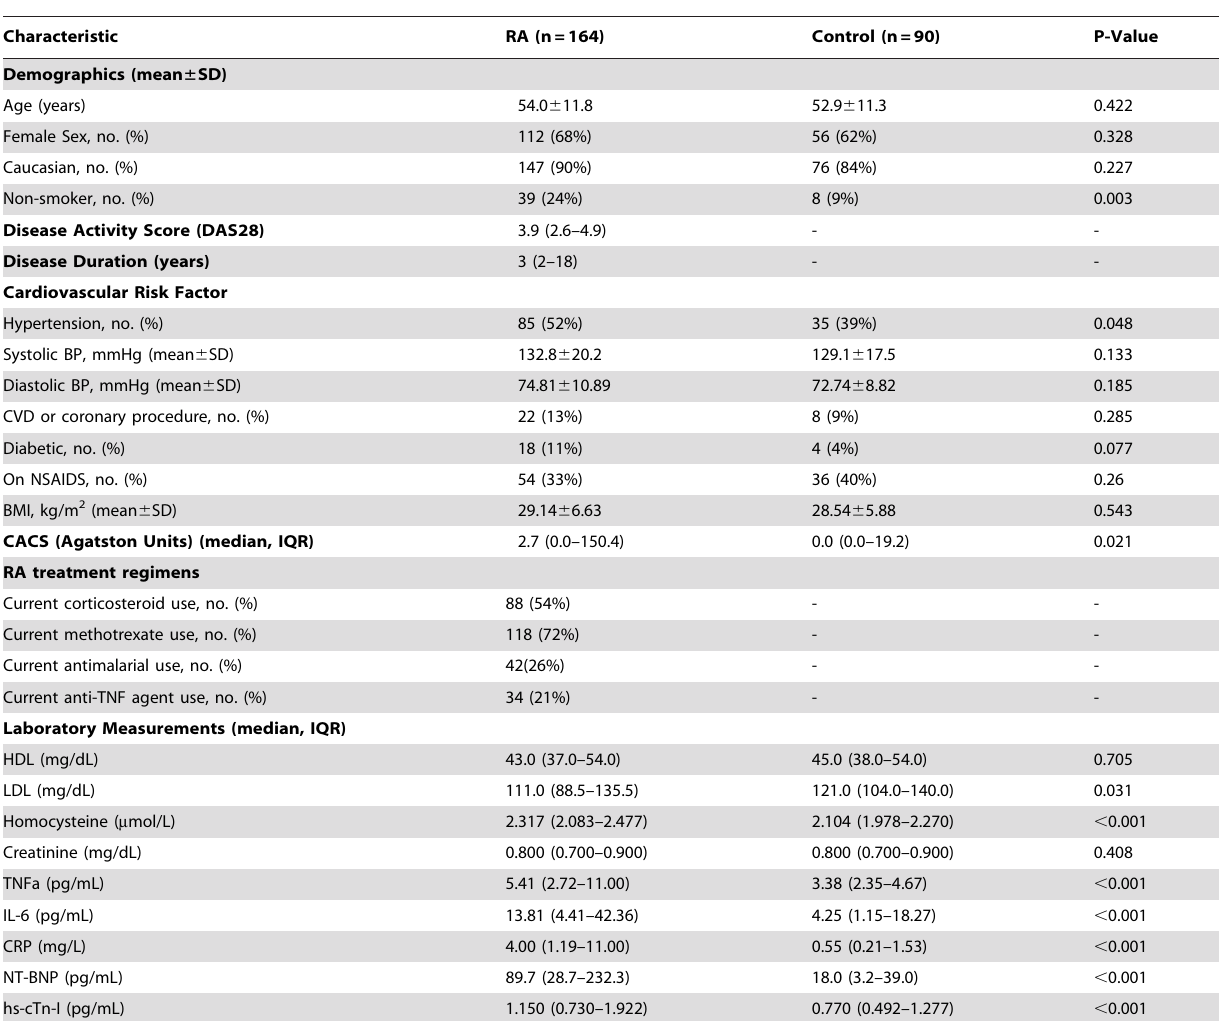
Table 1. Clinical Characteristics of Study